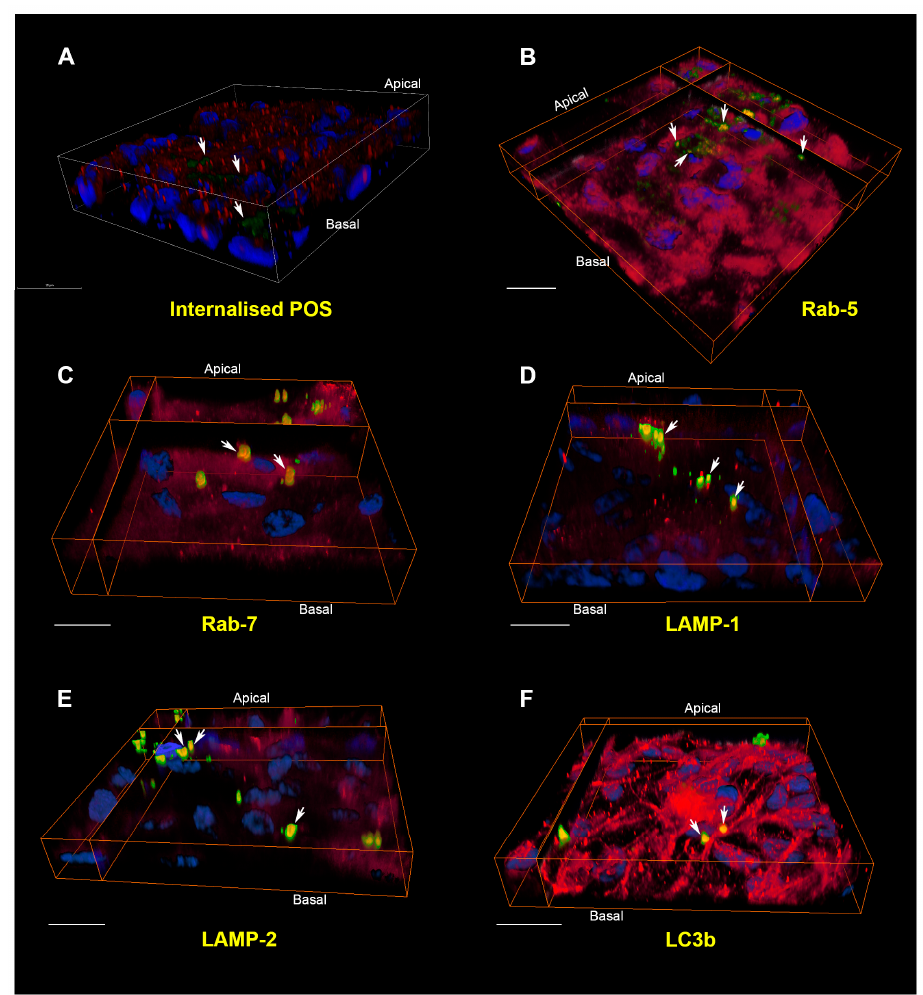
Figure 3. The internalisation pathway of photoreceptor outer segment cargo in RPE cells. ( A ) A pulse-chase assay in cultured RPE monolayers showed bound FITC-POS in green (arrows) at zero hours. Nuclei are stained with DAPI (blue) whilst Rab-5-positive vesicles appear in red. Note the lack of POS co-localising with early compartments at this initial stage. Scale bar in confocal orthogonal cross-section corresponds to 20 µ m; ( B ) 4 h following pulse-chase, POS may be observed in Rab-5 positive early compartments and appear as discrete yellow vesicles. ( C ) By 6 h, cargos had been trafficked to Rab-7 labelled late endosomes/phagosomes. ( D ) After 12 h, POS appear in vesicles labelled with the lysosomal marker LAMP-1. ( E ) At 24 h, POS were found in vesicles positive for the mature/late lysosomal marker LAMP-2. Note the perinuclear distribution typical of late compartments. ( F ) POS persisted in vesicles labelled with LC3b, a marker of autophagy bodies, as late as 48 h. The trafficking and processing of POS cargo through distinctive compartments can thus be visualised in cultured ARPE-19 cells. In all experiments, each compartment was labelled with a specific antibody (red), whilst POS-FITC and nuclei appear in green and blue, respectively. Areas of co-localisation between POS and the vesicle-specific marker appear yellow and are denoted by white arrows. POS that are trafficked through other compartments at a given time appear green, whilst areas of red indicate vesicles devoid of any cargoes. Scale bars in ( B – F ) correspond to 20 µ m. Panel A shows a conventional confocal z-stack, whilst panels ( B – F ) show three-dimensional RPE monolayers captured using a Leica SP8 confocal microscope (LAS X) and reconstructed using Amira 6.1